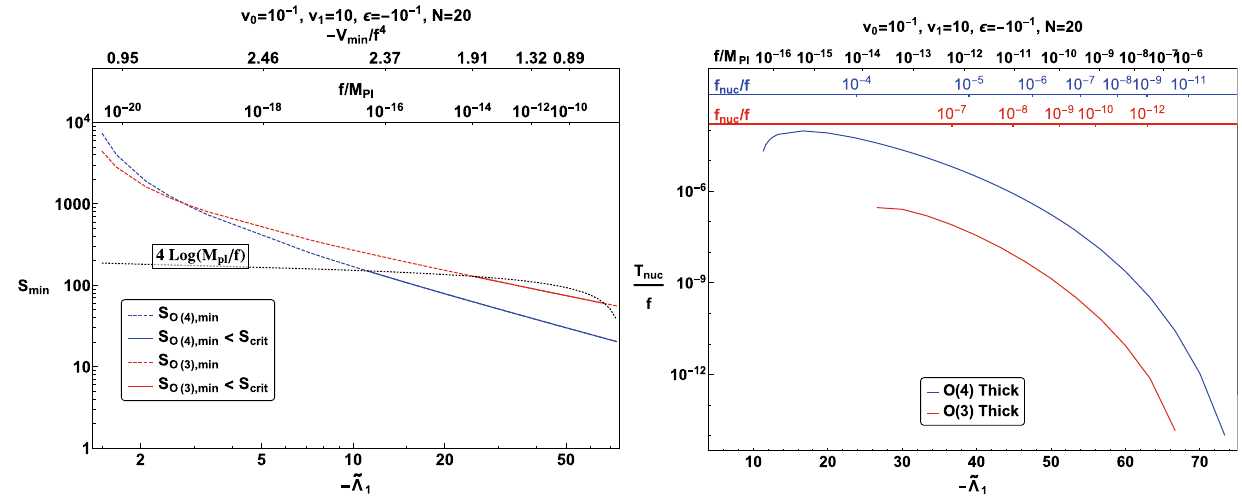
temperature, T n and the value of the nucleation condensate f n are very suppressed in relation to the value of f at the minimum of the